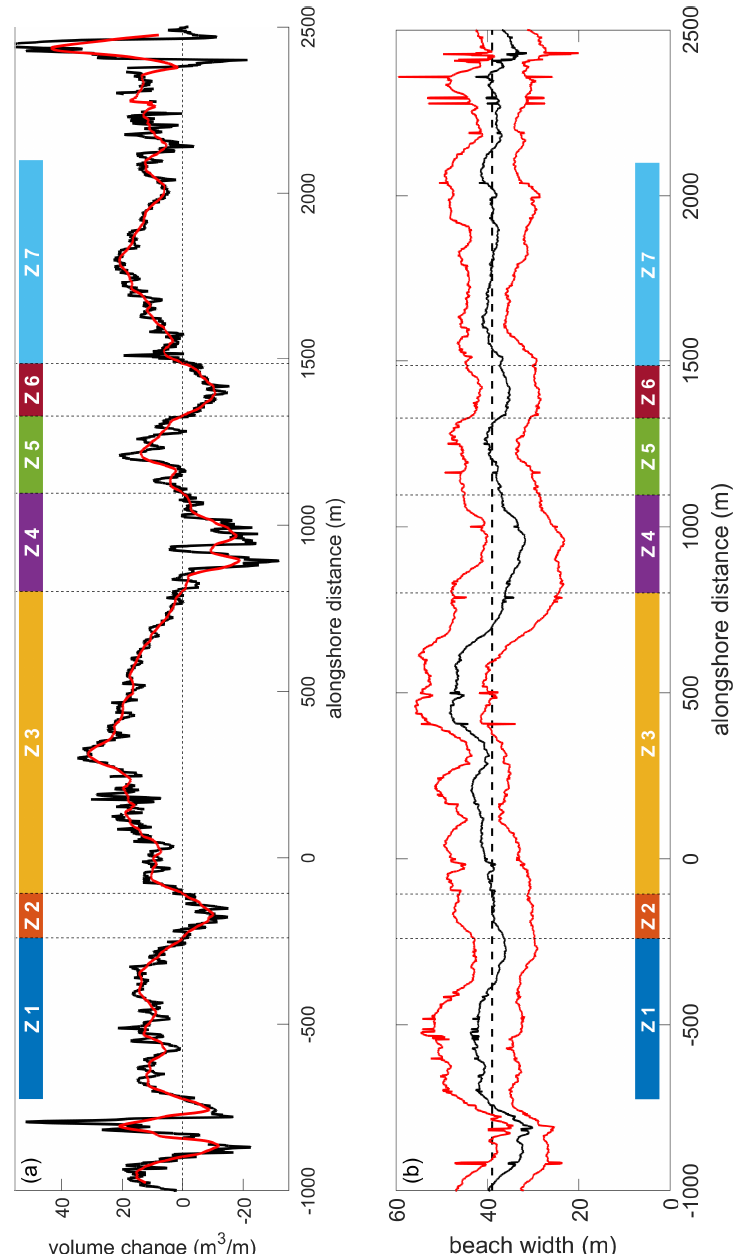
Figure 8. Volume change and beach width. ( a ) shows the alongshore variation in volume change between survey Dec13 and Apr15 (black line) with the alongshore volume changes after applying a 50-m averaging window (red line); ( b ) shows the average beach width over all surveys (black line) together with ± 1 standard deviation (red lines). The dashed line is the alongshore average beach width for zones 1 to 7. The Mar14 was excluded because of missing